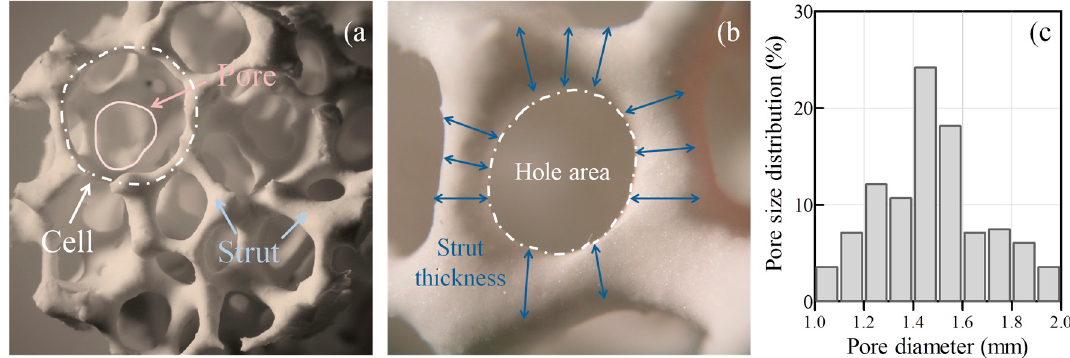
Figure 1. Geometric parameters ( a , b ) and pore diameter distribution ( c ) of 30 ppi alumina OCF